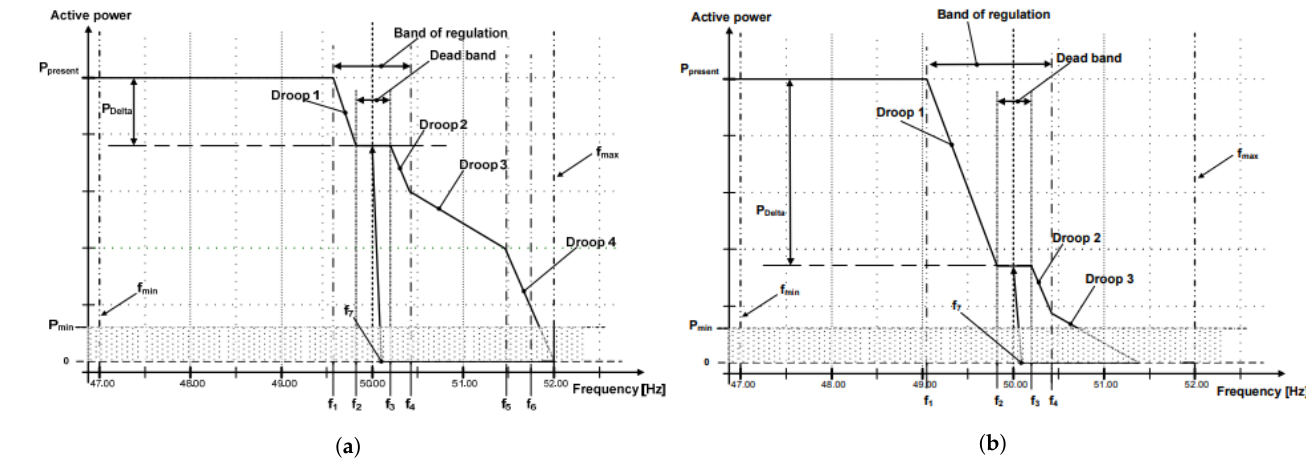
Figure 5. The plots shown here are the sensitive mode of droop control in the Danish grid from Danish grid code [15] The plots show ( a ) a case with low levels of reserve; ( b ) a higher level of